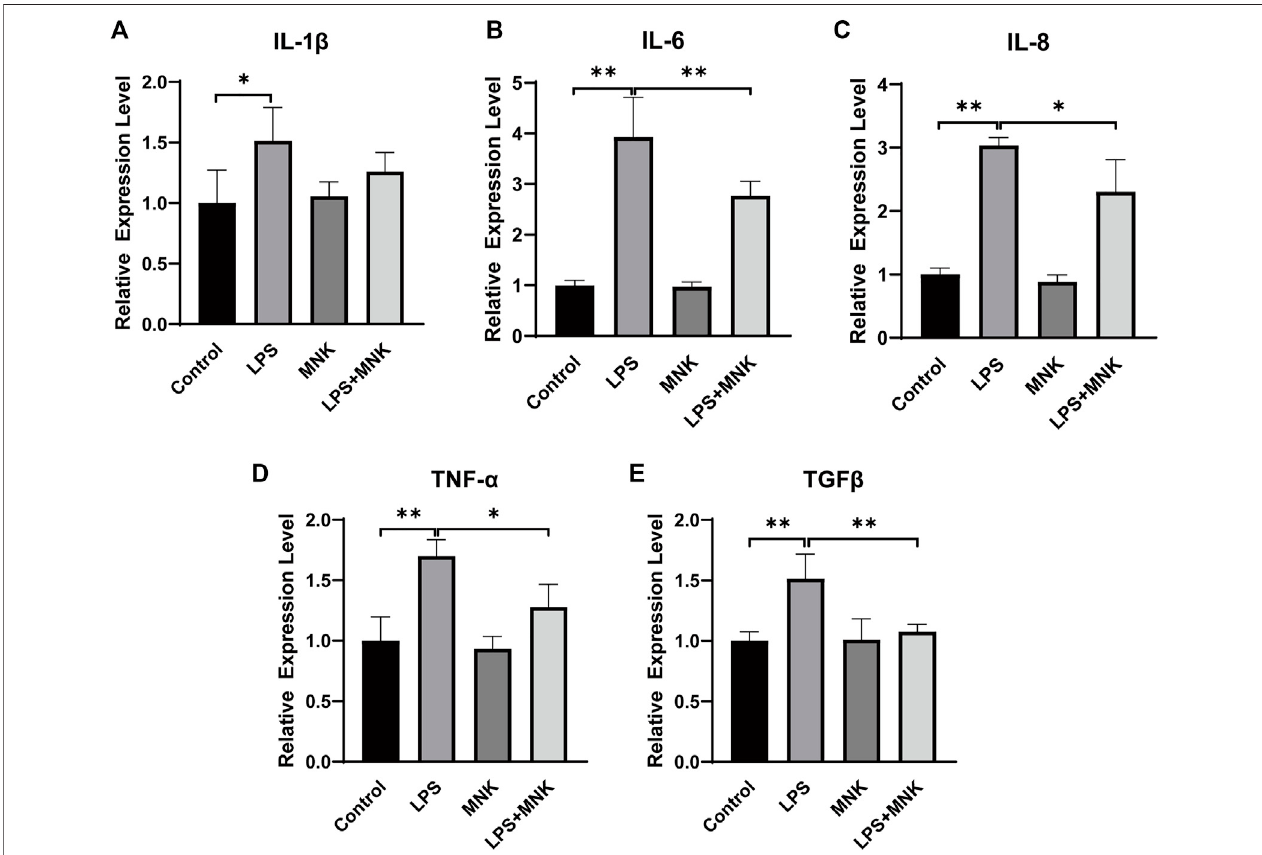
FIGURE 4 | Effect of 2-methyl nonyl ketone (MNK, 10 μ g/ml) on the relative mRNA expression levels of in fl ammation-related gene in lipopolysaccharide (LPS, 100 μ g/ml)-inducedMAC-Tcells. (A) Interleukin ( IL ) -1 β . (B) IL-6 . (C) IL-8 . (D) Tumornecrosisfactor- α ( TNF- α ). (E) Transforminggrowthfactorbeta (TGF β ) .Thedataare shown as mean ± SD. N (cid:1) 3. *, p < 0.05; **, p <